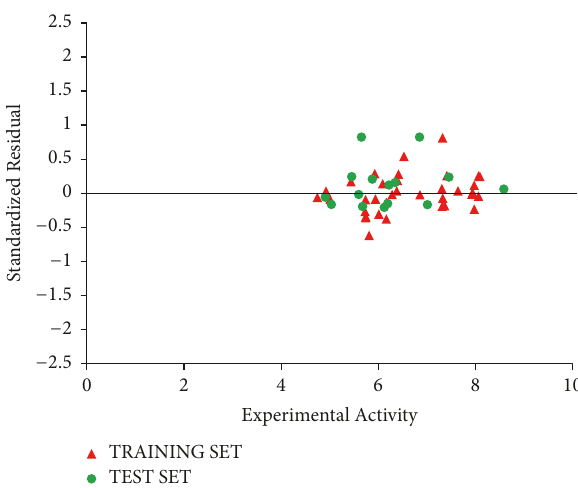
Figure 4: Plot of standardized residual activity versus experimental activity.